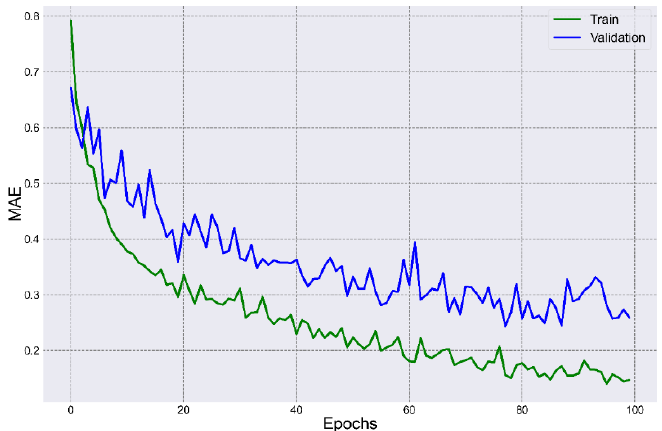
Figure 5. Comparison of the results of calculating the quality metric ( MAE ).